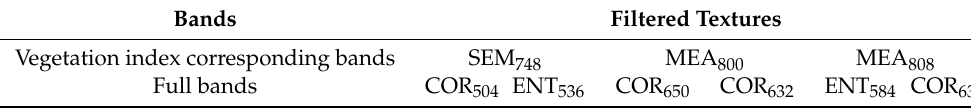
Table 5. Selection of the possible texture features. Bands Filtered Textures Vegetation index corresponding bands SEM 748 MEA